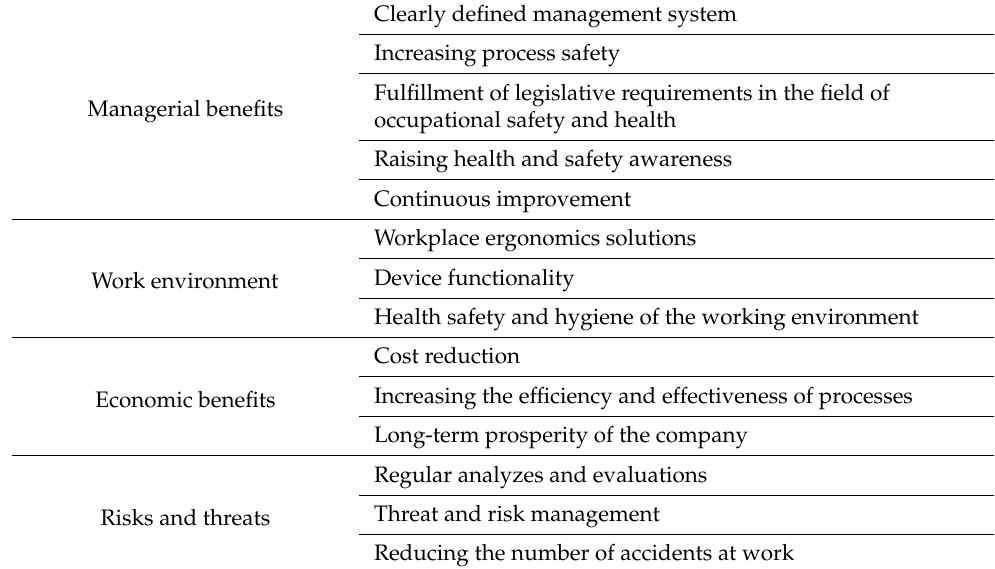
Table 4. Areas benefiting from the implementation and certification of the health and safety manage- ment system according to ISO 45001:2018 from the customer’s point of view